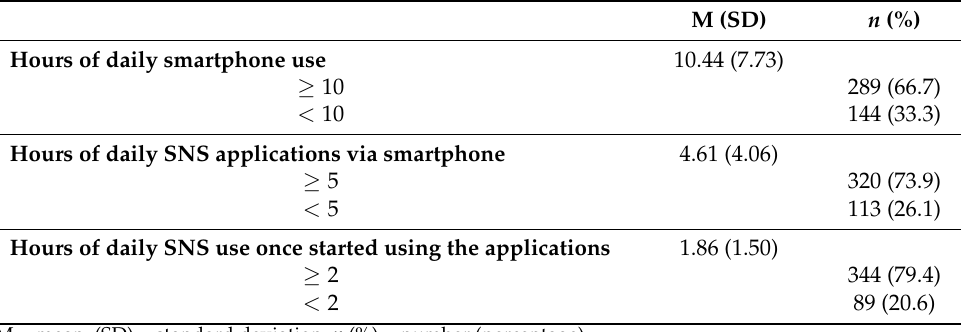
Table 2. Smartphone and SNS application use among participants ( n =